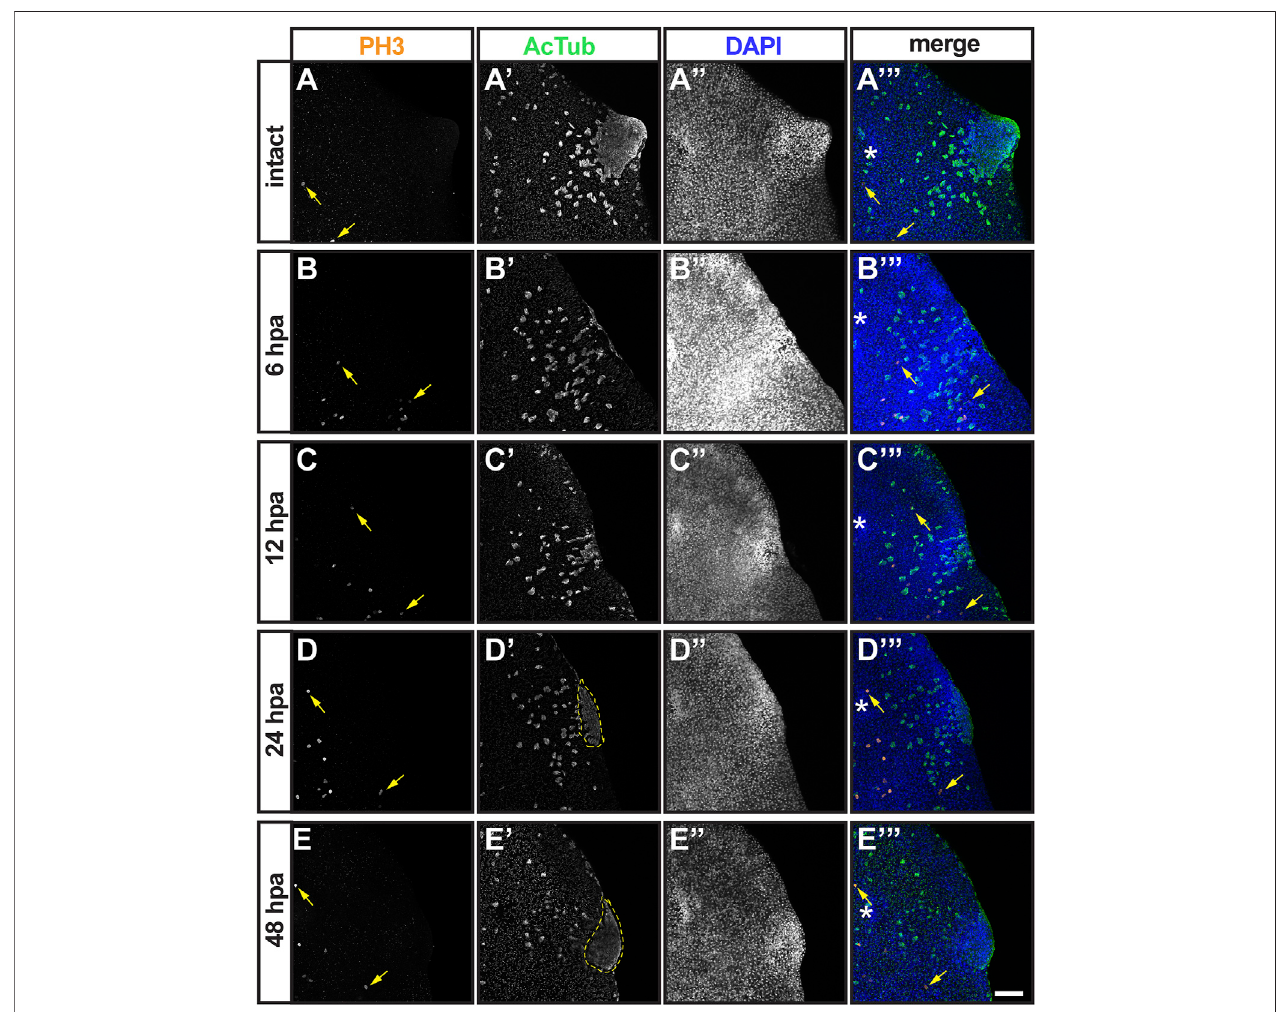
FIGURE6| Analysisofmitoticandciliatedcelldistributionduringthe fi rst2 dayspost-auricleamputation. Maximumintensityprojectionofconfocalz-stackimages from intact (A – A ”’ ) and auricle amputees 6 h post-amputation 6 hpa; (B, – B ”’ ) , 12 hpa (C – C ”’ ) , 24 hpa (D – D ”’ ) and 48 hpa (E – E ”’ ) , illustrate distribution of M-phase neoblastsstainedwithphospho-HistoneH3[PH3; (A – E) ;yellowarrows;orangein (A ”’– E ”’ ) andciliatedcellsstainedwithanti-acetylatedtubulinAcTub; (A ’– E ’ ) ;greenin (A ’– E ’ ) insetsand (A ’”– E ”’ ) .DAPIstainingofcellnuclei (A ”– E ” ) ;bluein (A ”’– E ”’ ) revealsthegeneralpositionofcells.Areaofaggregatedciliatedcells(dashedlines) was quanti fi ed ( Supplementary Material ). Asterisks [* in (A ’”– E ”’ ) ] mark position of eye. Scale (cid:2) 0.1 mm.